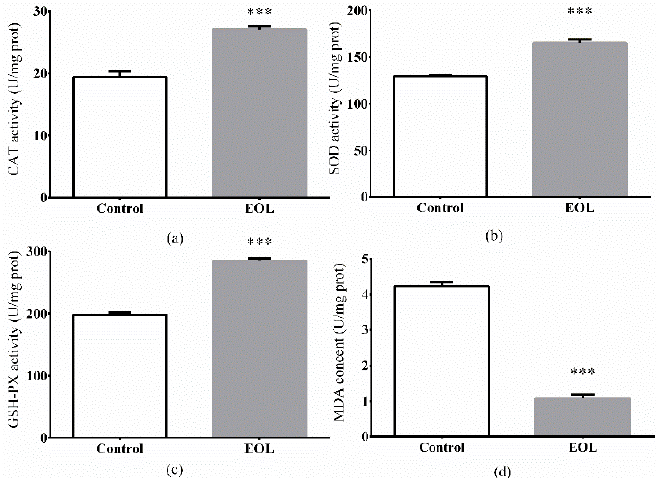
Figure 8. Effect of EOL on the activities of antioxidant enzymes under thermal stress. ( a ) CAT activity, ( b ) SOD activity, ( c ) GSH-PX activity, and ( d ) MDA content. Differences were considered to be significant at p < 0.001 (***).